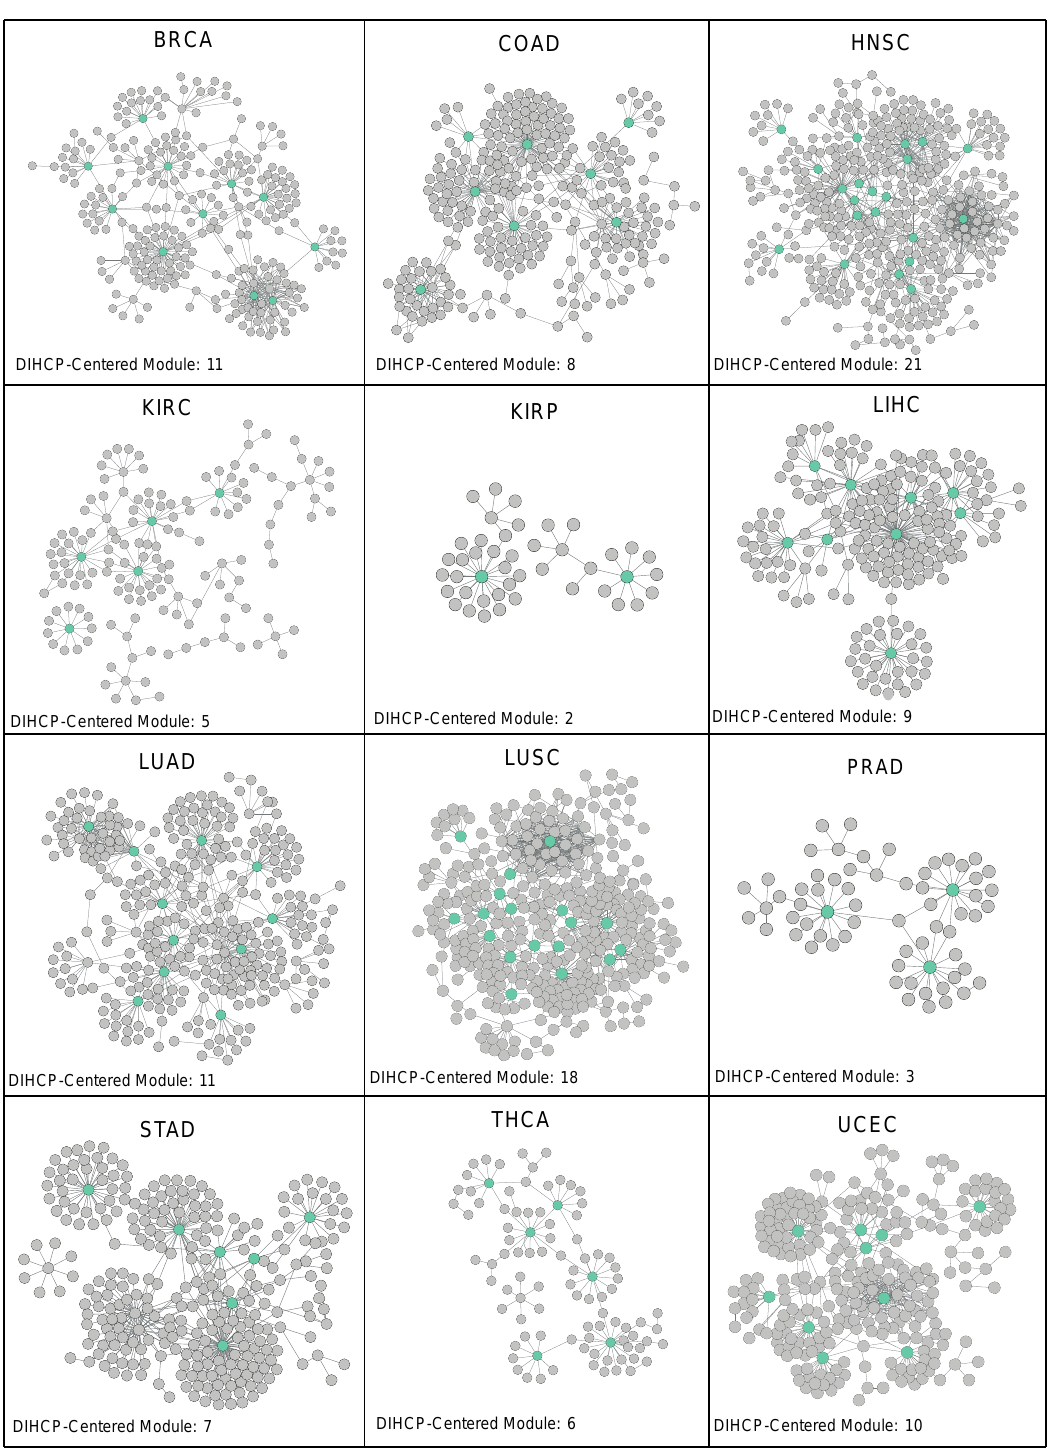
Figure 4. Differential interactome networks in 12 human cancers. For each cancer type, a differential interactome network was constructed around a differential hallmark of cancer-associated PPIs (dHCPPIs). The number of differentially interacting hallmarks of cancer proteins (DIHCPs) for each cancer type was